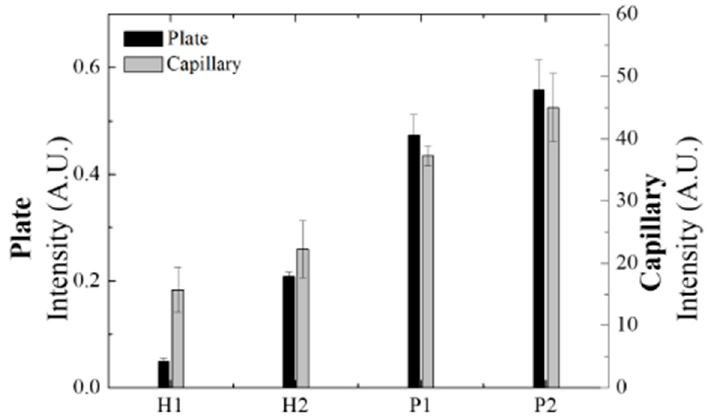
Figure 6. The feasibility evaluation of using glass capillaries for clinical serum specimen anti-p53 autoantibody immunoassay.